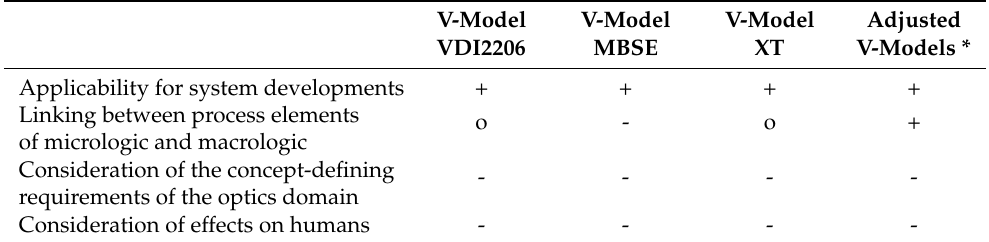
Table 1. Evaluation of interdisciplinary development processes based on the imposed requirements. fulfilled (+), partially fulfilled (o), not fulfilled (-) according to [9].